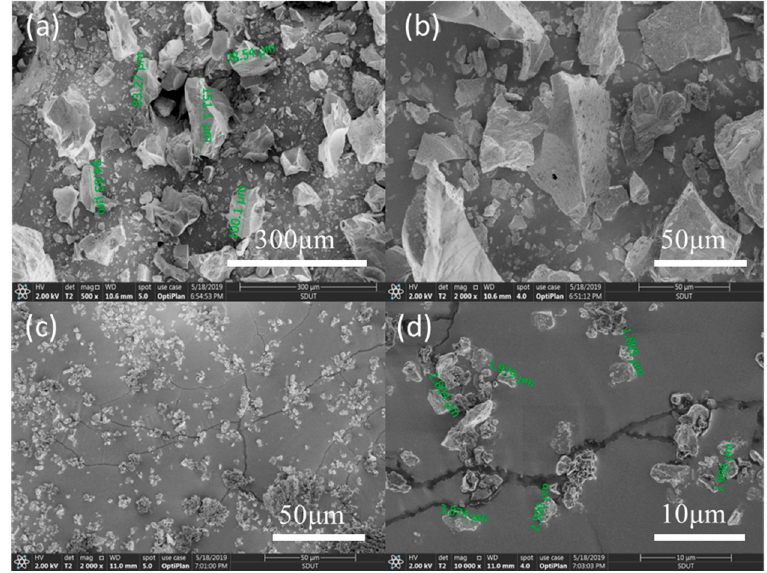
Figure 3. SEM micrographs of the lunar regolith simulants powder. ( a , b ) before the ball mill. ( c , d ) after the ball mill.